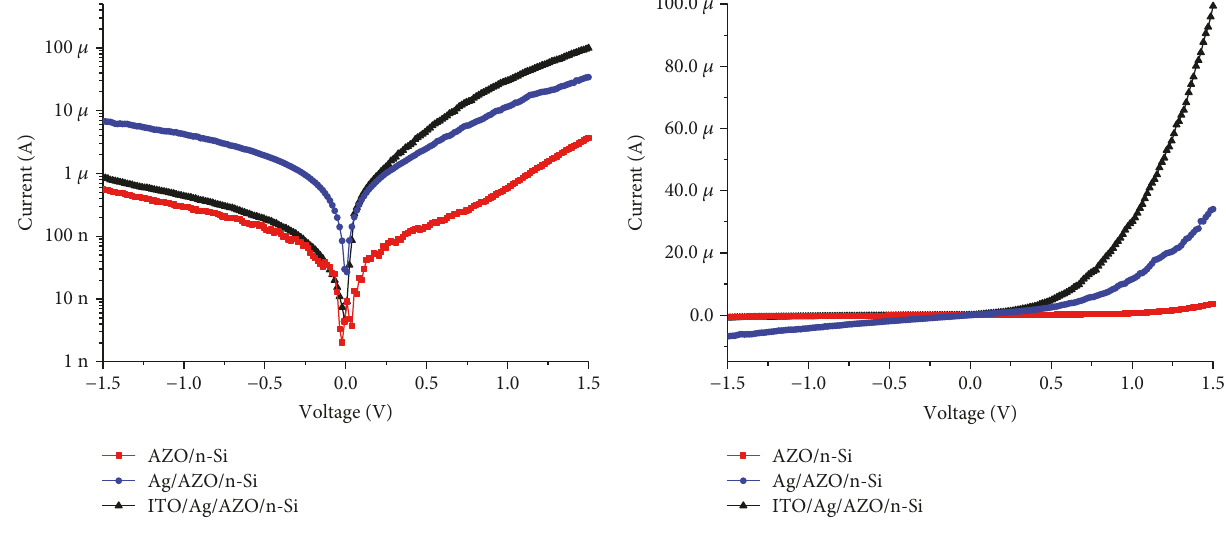
Figure 5: Dark I – V pro fi les of S1, S2, and S3 devices. Table 2: The characterized electrical and optical parameters of AZO, Ag/AZO, and ITO/Ag/AZO devices. Sample device Figure of merit Rectifying